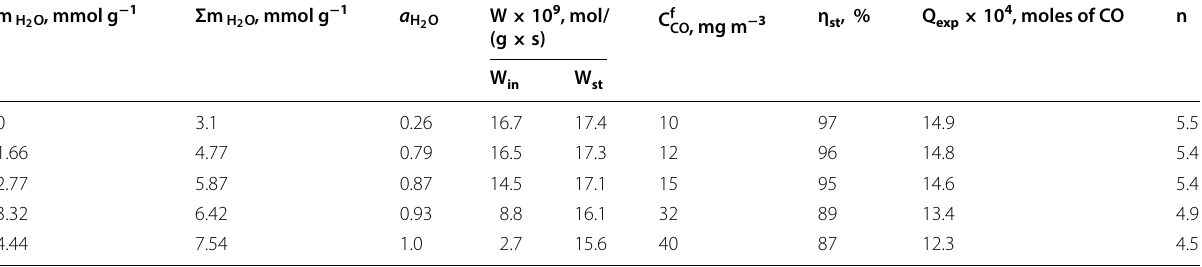
C Pd(II) 2.72 10 − 5 , C Cu (II) = × At a H 2 O close to 1.00, the catalyst loses its protective properties